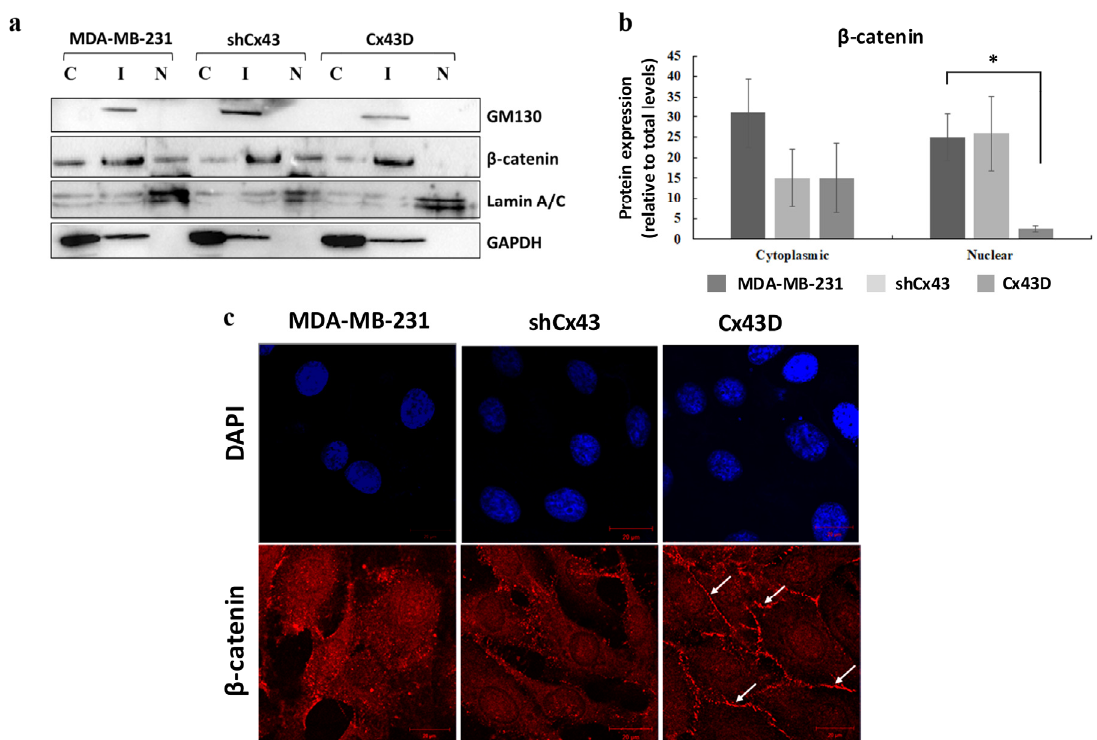
Figure 5. Cx43 over-expression sequesters β -catenin at the cell membrane in MDA-MB-231 cells. ( a ) Western blotting of β -catenin in cellular fractions of MDA-MB-231 cells, shCx43 cells and Cx43D cells. Proteins from the cytosolic (C), intermediate (I) and nuclear (N) fractions were blotted with compartment-specific antibodies, GAPDH, GM130 and Lamin A/C, respectively. ( b ) Bar graph displaying the densitometry analysis of nuclear versus cytosolic β -catenin expression with respect to total β -catenin protein levels. Two independent experiments were performed and plotted. ( c ) Representative immunofluorescence images of β -catenin expression in parental MDA-MB-231, shCx43 and Cx43D cells, counterstained with DAPI. Micrographs are representative of at least ten different fields per cell line. Scale bar represents 20 µm. * p < 0.05.